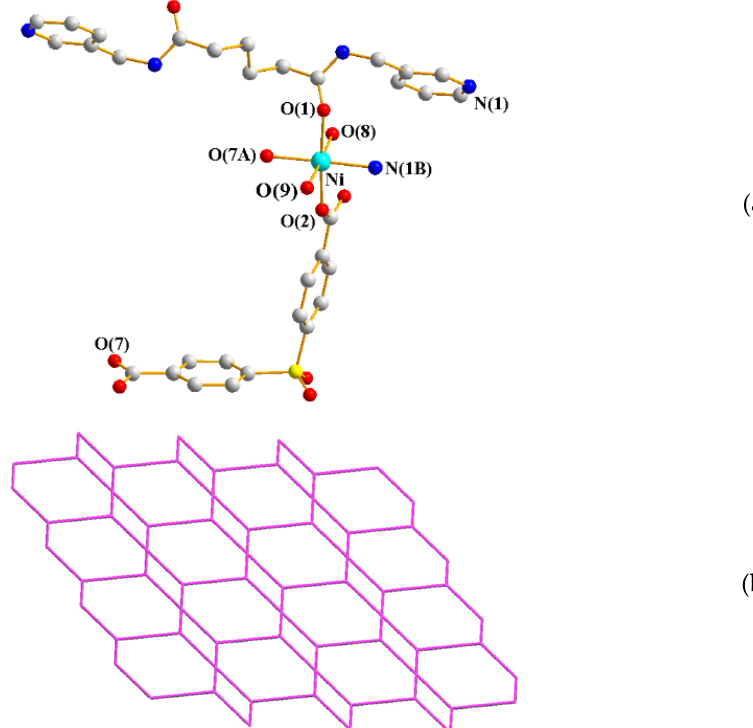
Figure 8. ( a ) Coordination environment of Ni(II) ion in 9 . Symmetry transformations used to generate equivalent atoms: (A) − x + 1, − y + 2, − z + 2; (B) − x + 1, − y + 1, − z + 1. ( b ) A drawing showing the 3,4L13 topology.